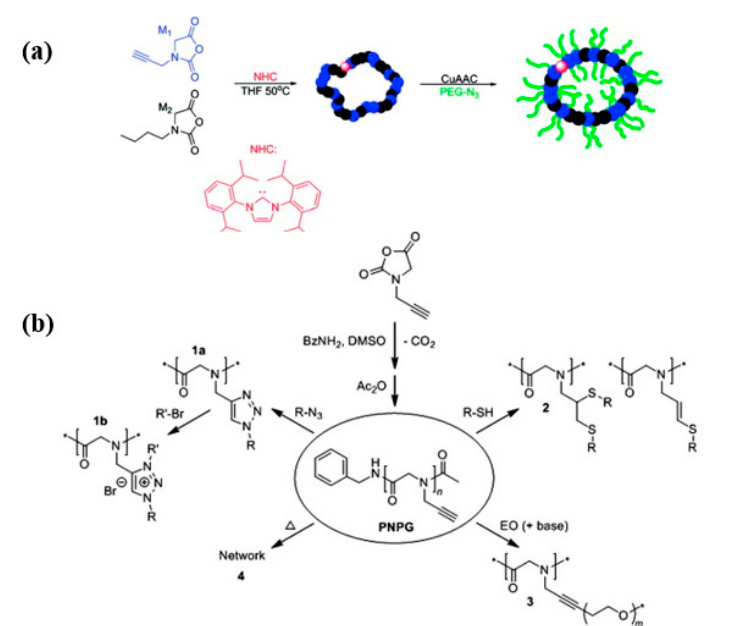
Figure 1. ( a ) The formation of cyclic brush-like polymers from the reaction of azido-terminated poly(ethylene glycol) (PEG) and cyclic poly( N -propargyl glycine)- ran -poly( N -butyl glycine) copolypeptoids bearing propargyl side chains. Reprinted with permission from [42]. Copyright 2011, American Chemical Society. ( b ) Synthesis of poly( N -propargyl glycine) and subsequent modifications of alkyne side chains. Reprinted with permission from [48]. Copyright 2015, Elsevier.